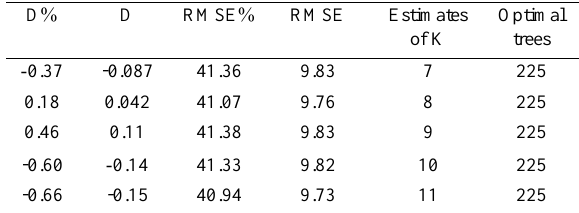
Table 3 shows the results of the evaluation criteria of the random forest algorithm with the different number of Kin